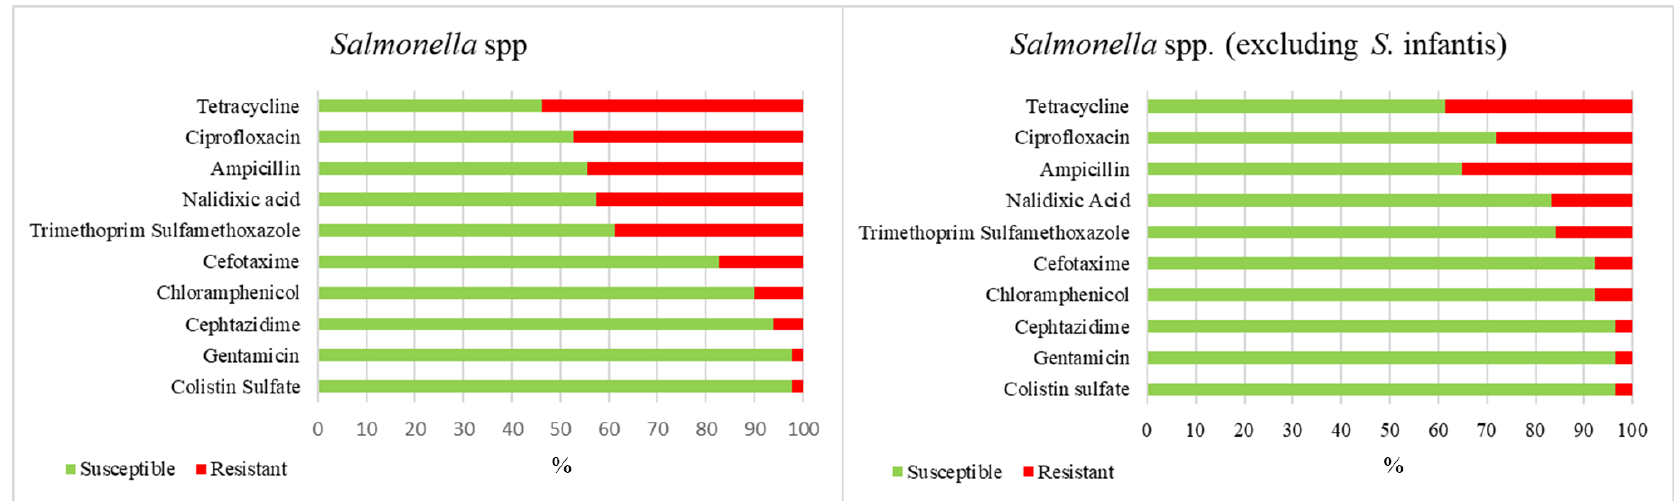
Figure 1. Overall occurrence (%) of susceptibility and resistance to 10 antimicrobials in all Salmonella serovars before and after excluding the S. Infantis serotype.